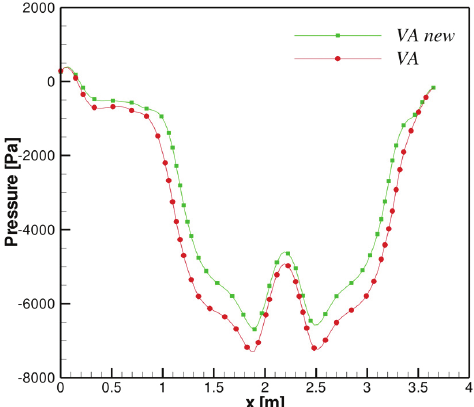
Figure 28 - Variations in the mean pressure along the rotor for the original and modified geometries.